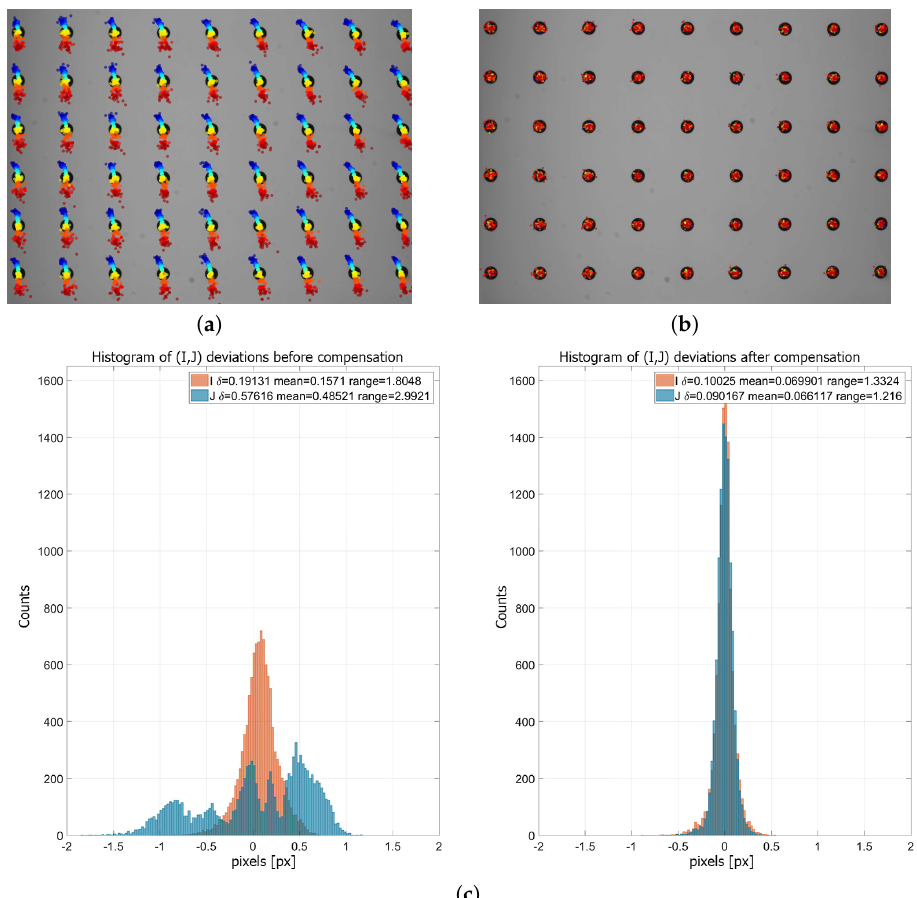
Figure 11. Compensation results. ( a ) Calculated thermal drift (multiplied × 100) for the marker centers used to prepare the compensation model. ( b ) Result of compensation and ( c ) histogram of deviation of coordinates, before and after compensation (fourth-degree polynomial).